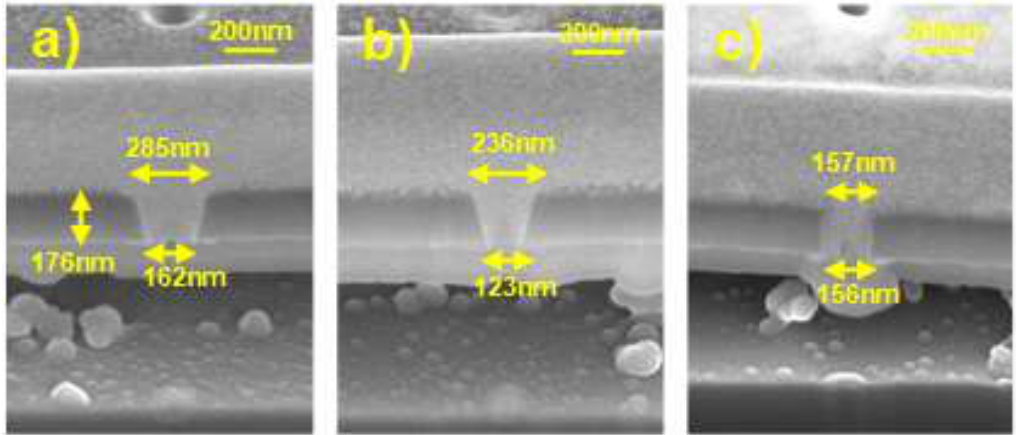
Figure 3. Cross-sectional scanning electron microscopy (SEM) images of etch holes with the variation of the beam current and target diameter of the focus ion beam (FIB) process. ( a ) Aspect ratio = 0.79 when beam current is 50 pA and target diameter is 160 nm; ( b ) Aspect ratio = 1.01 when beam current is 10 pA and target diameter is 160 nm. ( c ) Aspect ratio = 1.14 when beam current is 10 pA and target diameter is 80 nm.